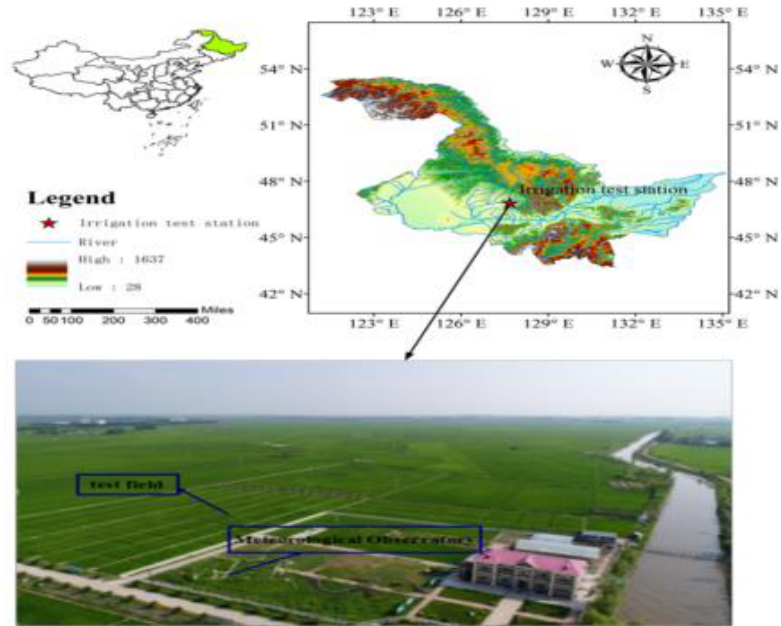
Figure 1. Location of study site